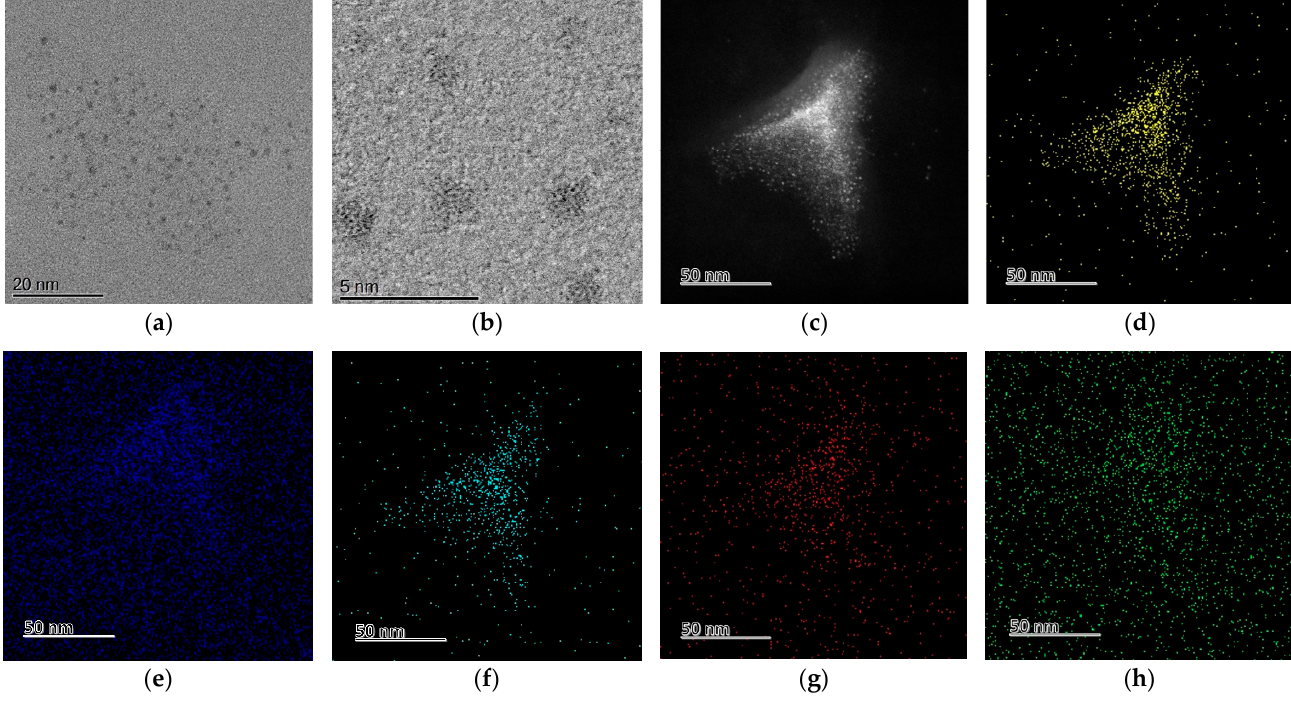
Figure 4. Scanning Transmission Electron Microscopy (STEM) images showing Au clusters within nanoparticles ( a , b ), and Energy Dispersive Spectroscopy (EDS) maps of the nanoparticle material showing the ( c ) unfiltered signal and the filtered signals from; ( d ) gold; ( e ) carbon; ( f ) sulfur; ( g ) nitrogen; ( h ) oxygen.